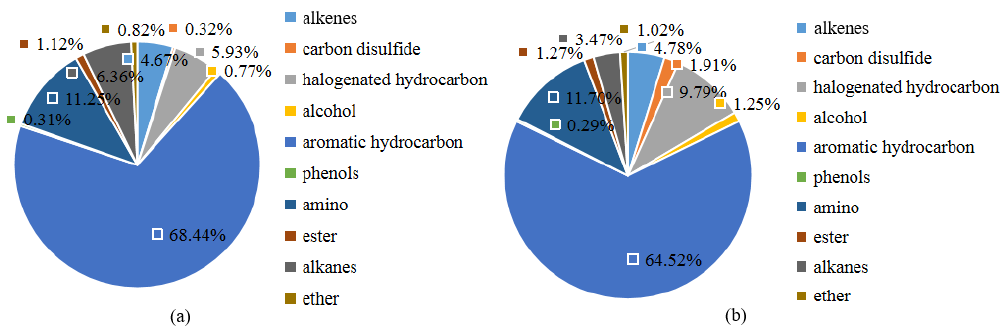
Figure 5. The VOC content distribution. ( a ) The content distribution of VOCs near Qianhui Pharmaceutical. ( b ) The content distribution of VOCs near the Naxin Daily Necessities store. Note: The SPI-TOFMS cannot distinguish isomers when measuring VOCs.